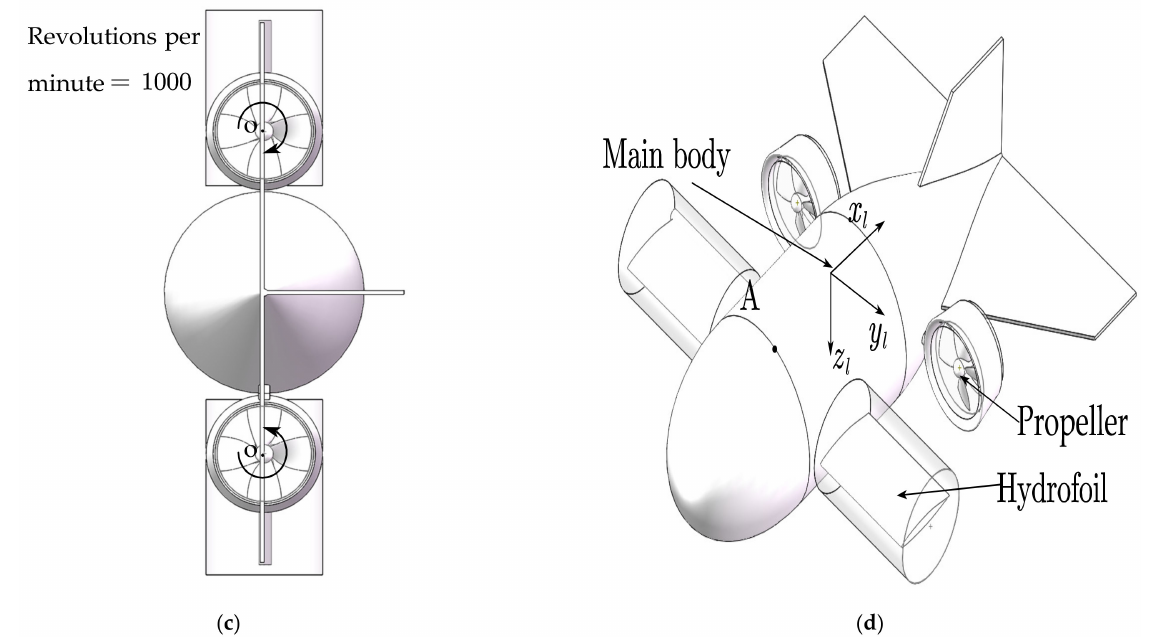
Figure 3. The profile of the tethered underwater robot: ( a ) the front view of the tethered underwater robot and rotation angle of hydrofoils; ( b ) the top view of the tethered underwater robot; ( c ) the back view of the tethered underwater robot and direction of rotation; ( d ) the isometric view of the tethered underwater robot. Table 1. Primary parameters of the tethered underwater